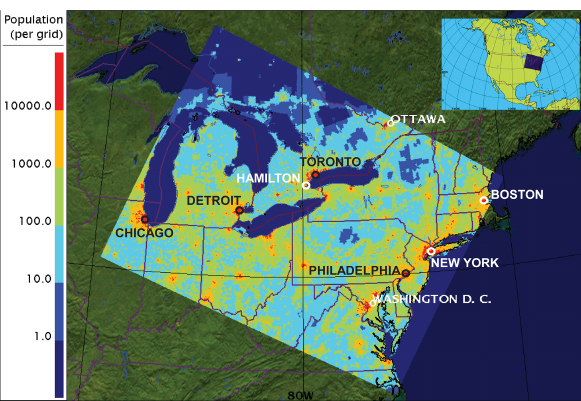
Figure 1. Model domain, coloured on a logarithmic scale by the human population per 2 . 5km × 2 . 5km model grid